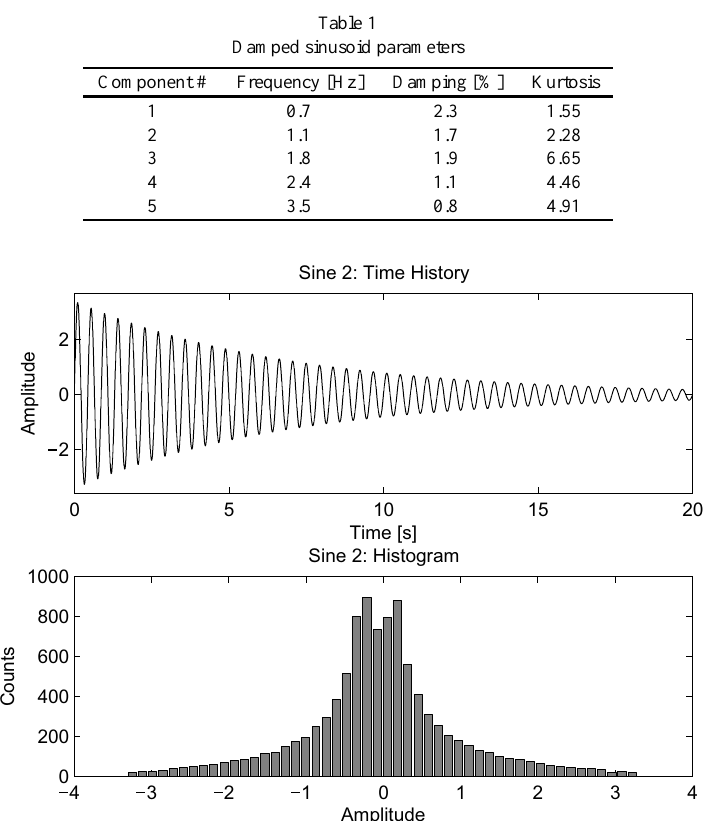
Fig. 5. Damped sinusoid x 2 (t) (top) and its histogram (bottom) – ku ex =